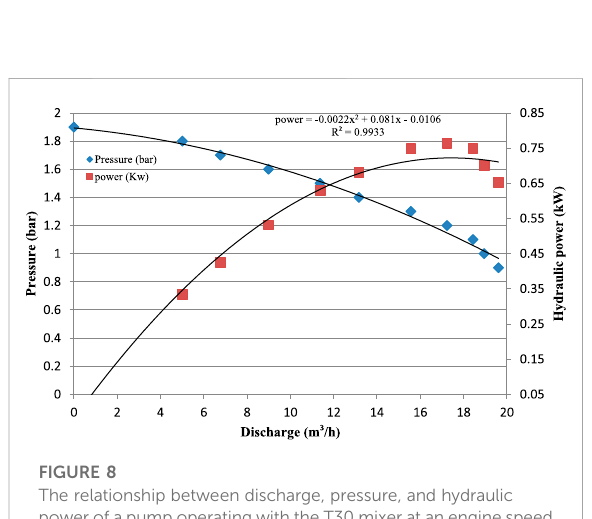
FIGURE 8 The relationship between discharge, pressure, and hydraulic power of a pump operating with the T30 mixer at an engine speed of 3,500 rpm.